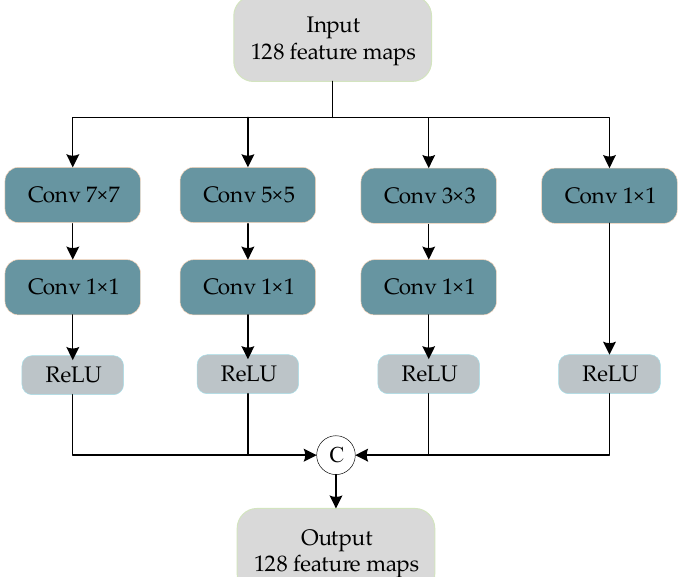
Figure 3. Multiscale feature extraction block structure.